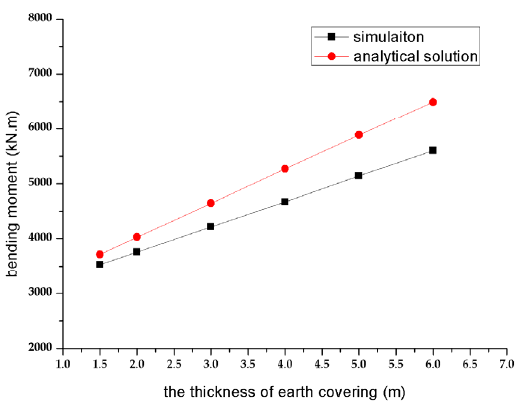
Figure 18. Relation curve of the column bottom bending moment with the thickness of earth covering. From Table 4, the error between analytical solutions and the simulation results ranges from 4.9% to 13.7% under the different thicknesses of the earth covering. The error increases with the thickness of the earth covering in the acceptable scope, and the analytical solution has the advantage of high goodness of fit and satisfactory effect. Table 4. The comparison between simulation and analytical solution within different thickness of earth covering. The Thickness of The Error Analytical Solution Simulation Earth Covering